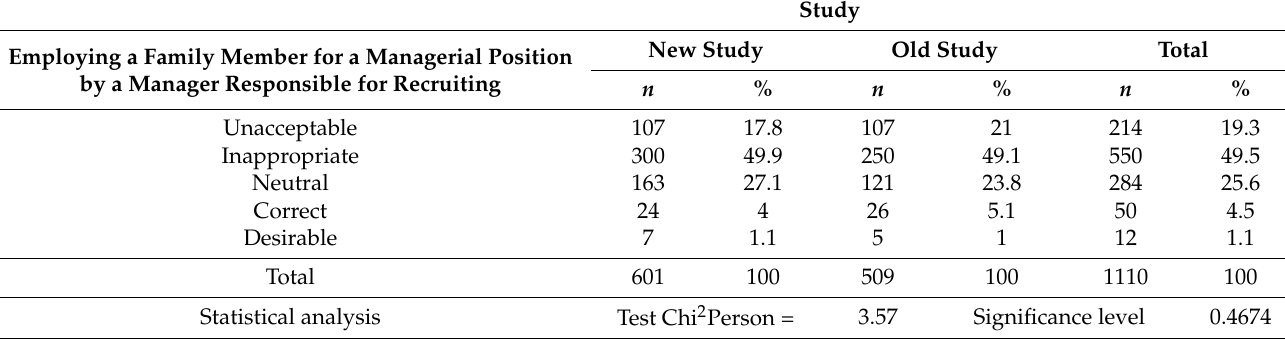
Employing a Family Member for a Managerial Position by a Manager Responsible for Recruiting